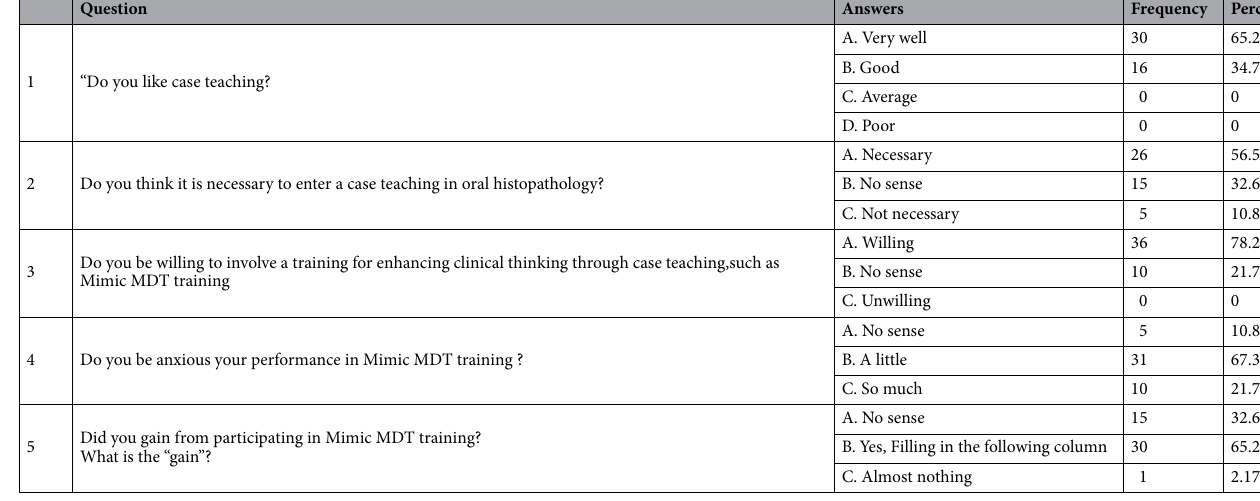
Table 1. Survey on the recognition of Mimic MDT training based on case-teaching.